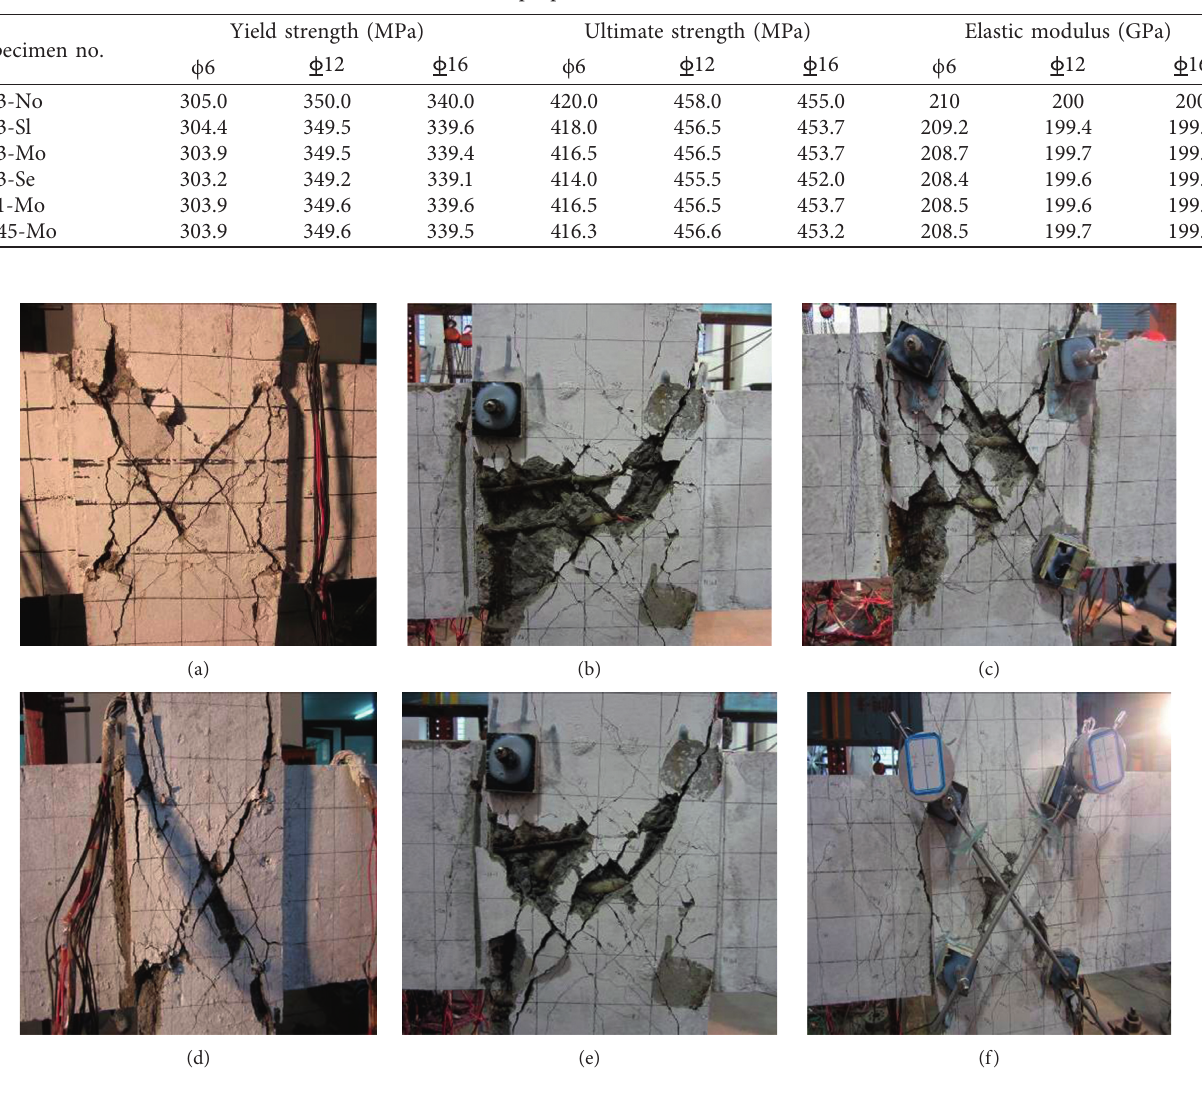
Figure 6: Failure patterns of specimens. (a) 0.3-No. (b) 0.3-Sl. (c) 0.3-Mo. (d) 0.3-Se. (e) 0.1-Mo. (f)